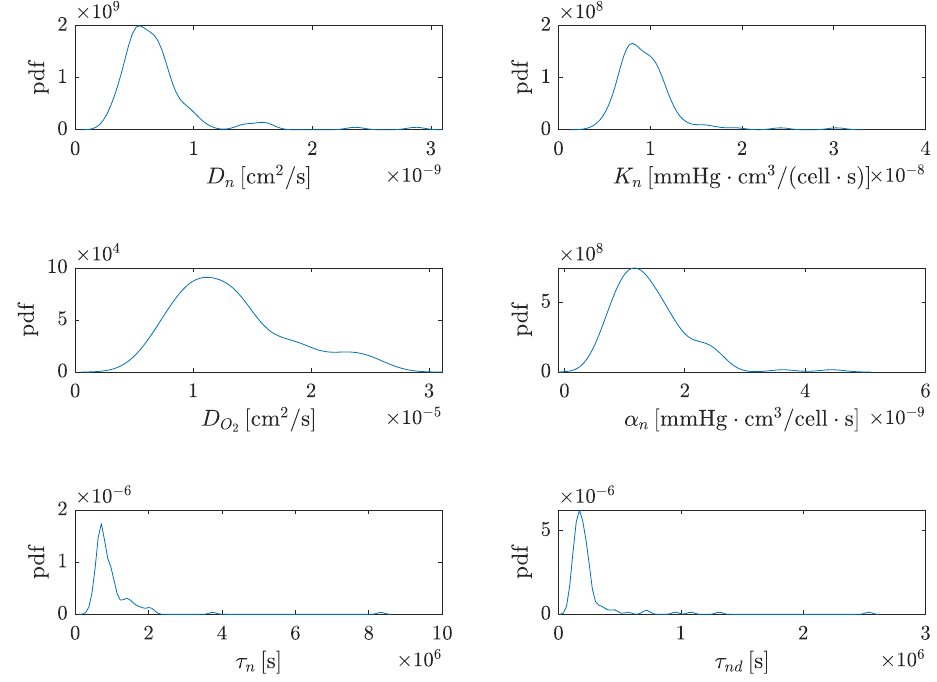
Figure 2. Kernel density estimation of the marginal